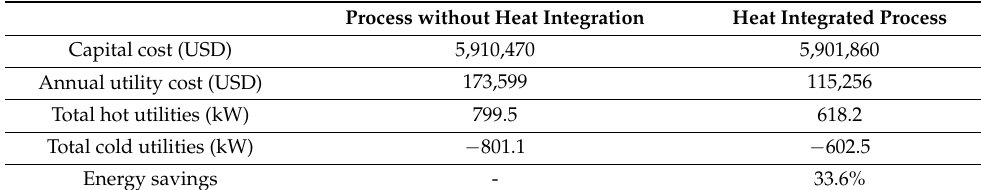
Figure 5. Heat integrated process flowsheet for the production of high purity biodiesel.